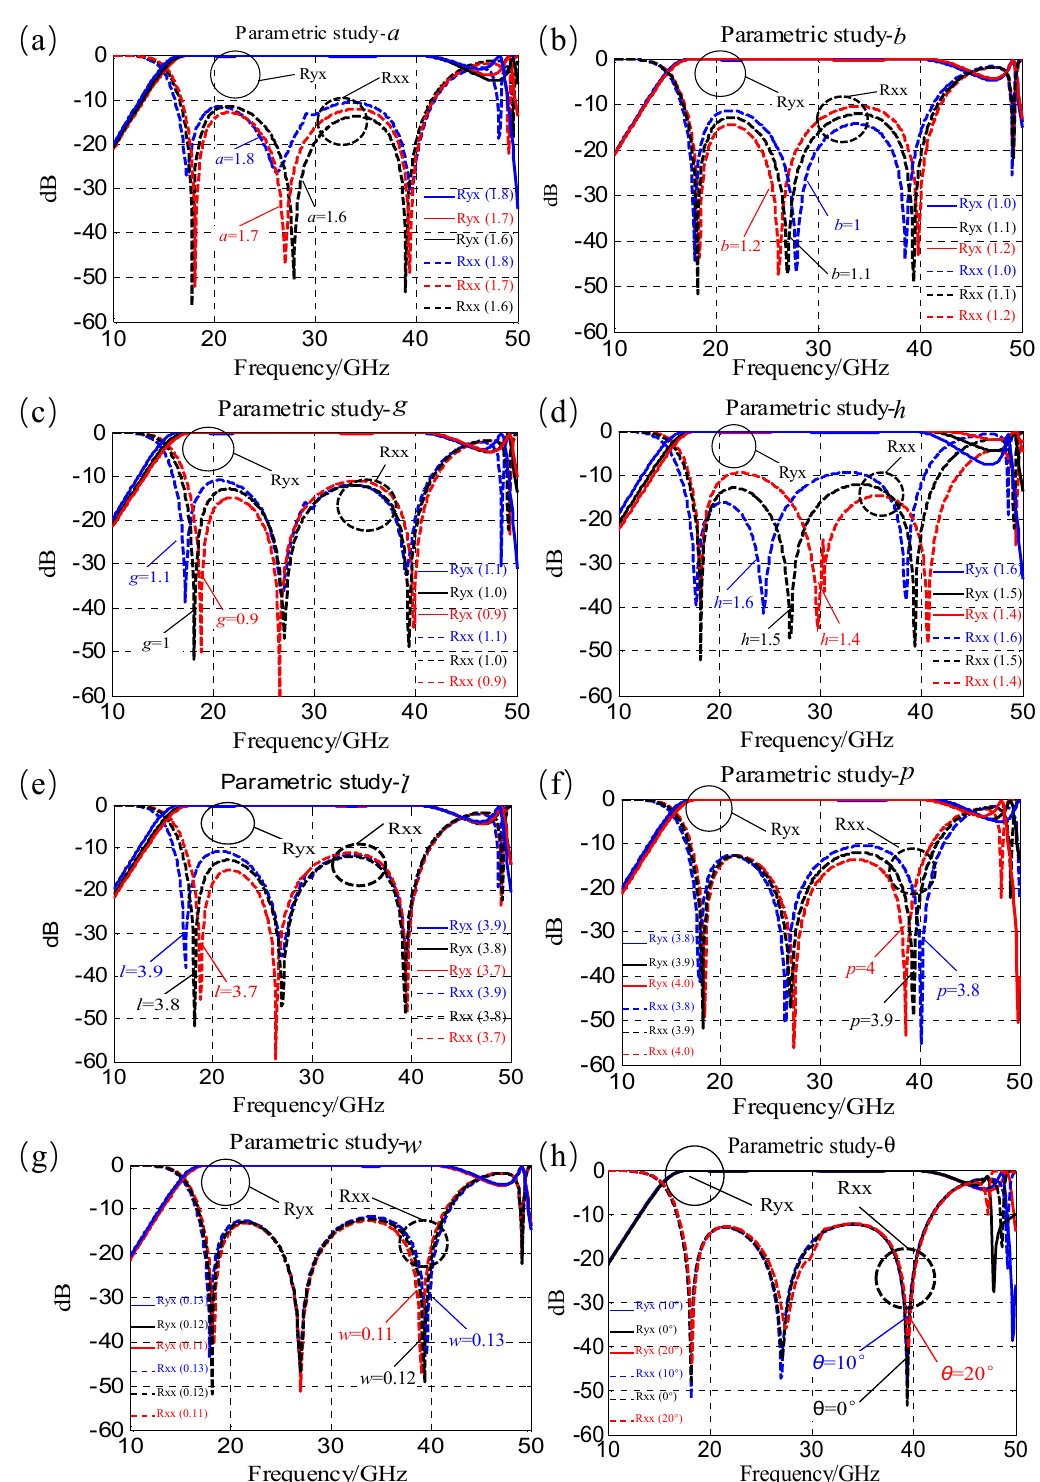
Figure 5. Parametric study for parameters ( a ) a , ( b ) b , ( c ) g , ( d ) h , ( e ) l , ( f ) p , ( g ) w , ( h ) θ . The fabrication accuracy is 10 μ m, the step is 10 μ m for w and 100 μ m for other parameters.